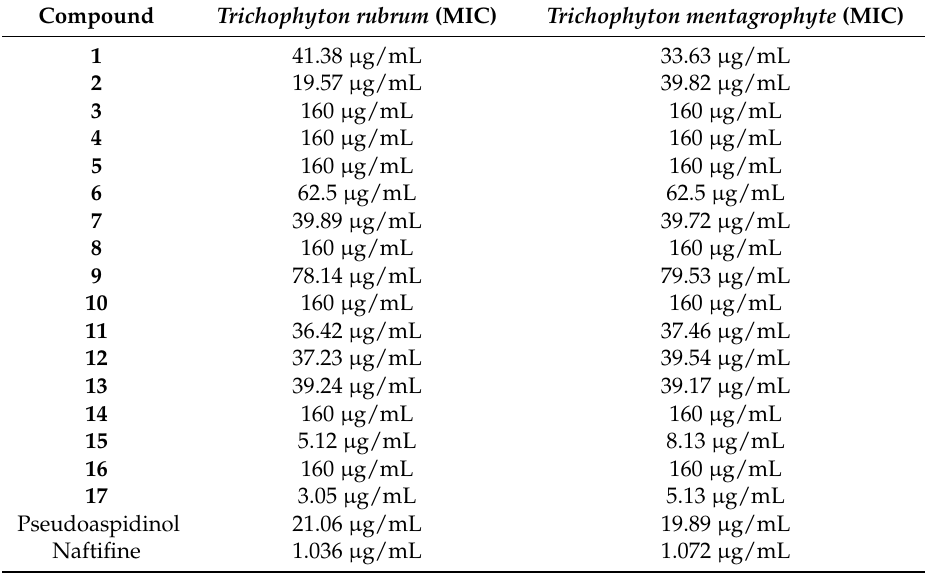
Table 1. Antifungal activities of compounds on Trichophyton rubrum (Tr) and Trichophyton mentagrophytes